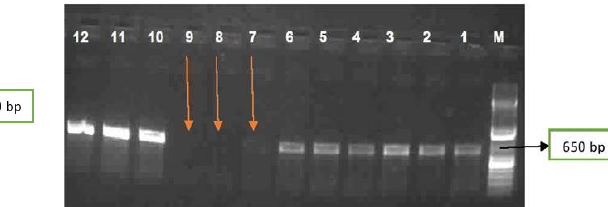
Fig. 4. Gel image of ITS primer amplified Inula gDNA’s by